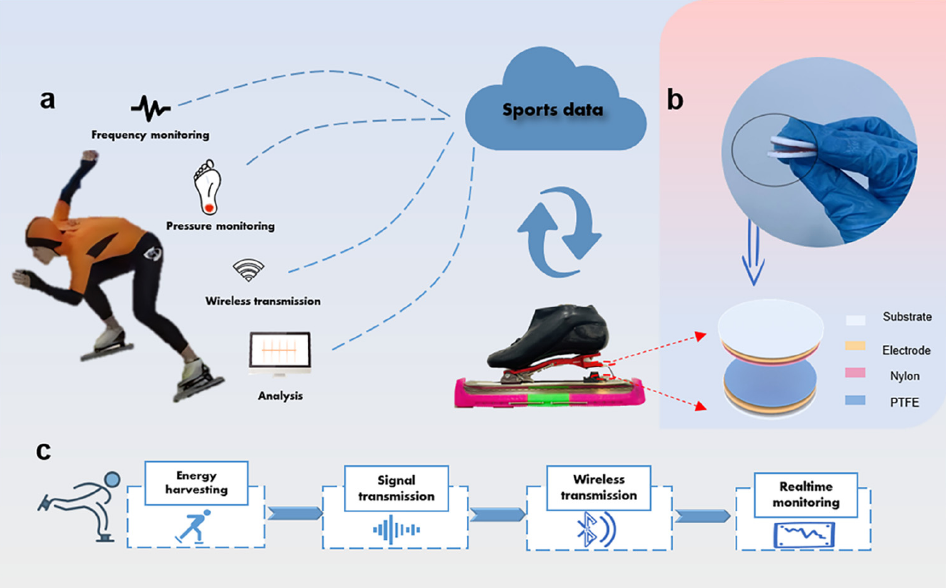
Figure 1. Experimental design of a self-powered motion sensor for skating technology monitoring. ( a ) Schematic diagram for monitoring frequency and force of skating pedaling. ( b ) Optical image and structure of the sensor. ( c ) Block diagram of the system showing energy collection, signal transmission and wireless monitoring.